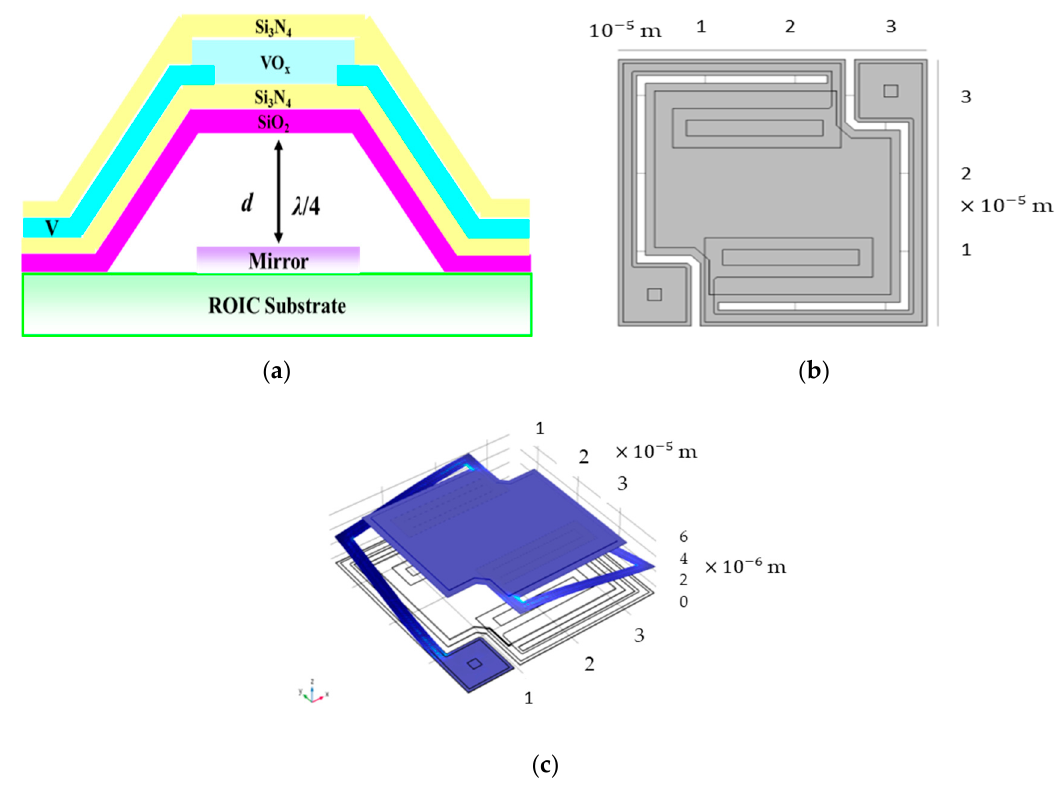
Figure 1. ( a ) Schematic of cross-sectional single-element microbolometer detector; ( b ) Top-view single-element microbolometer detector; ( c ) 3D single-element microbolometer detector. Table 1. Material characteristic parameters of suspended and sandwiched structure for Microbolometer detector.